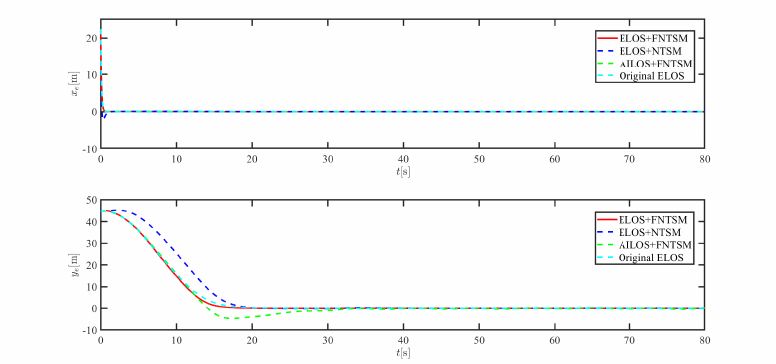
Figure 22. Comparison results of curve line trajectory tracking at fast speed.